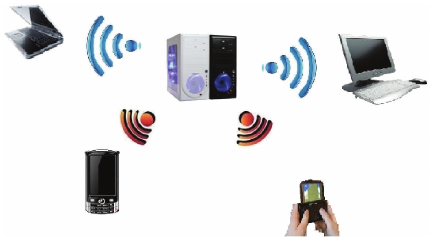
Figure 1: A wireless communication scenario.